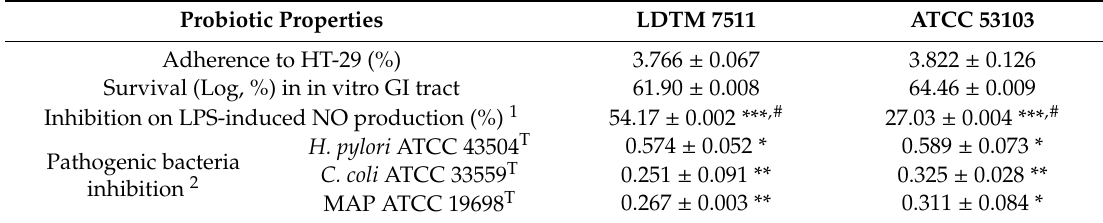
Table 1. In vitro characteristics of potential probiotics.